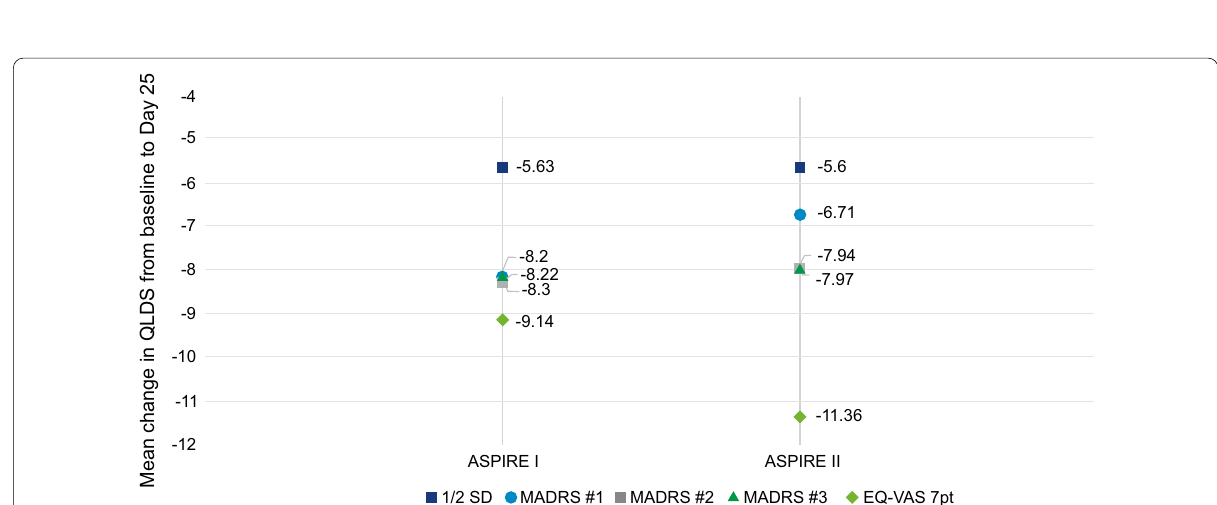
Fig. 2 ASPIRE II–mean change in QLDS score from baseline to Day 25 using MADRS as an anchor. Values are represented as mean was categorized as: severity criteria #1—no depression (score 0–12), slight depression (score 13–21), moderate depression (score 22–28), and severe depression (score > 28–60); severity criteria #2—no depression (score 0–6), mild depression (score 7–19), moderate depression (score 20–34), and severe depression (score > 34–60); and severity criteria #3—no depression (score 0–12), mild depression (score 13–17), moderate depression (score 18–34), and severe depression (score > 34–60). CAT Category, CI Confidence Interval, IMP Improvement, MADRS Montgomery–Åsberg Depression